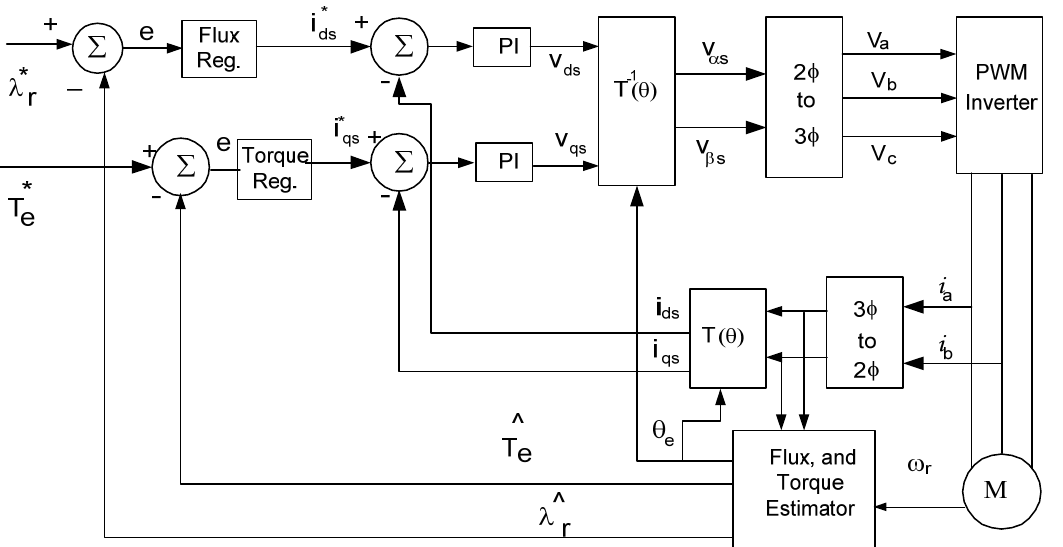
Figure 2. Direct Field Oriented (DFO) drive